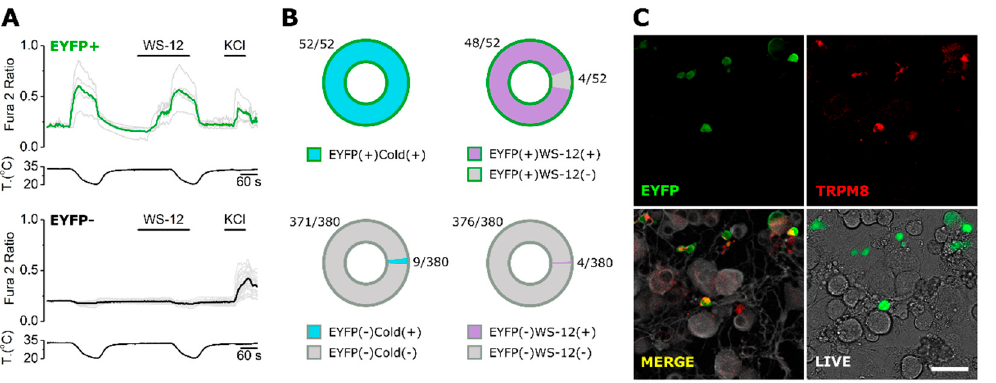
Figure 4. Calcium imaging in DRG-cultured cells from Trpm8 BAC -EYFP + mice. ( A ) Representative traces of calcium transients evoked by mild cold ( ∼ 18–20 °C), WS-12 (10 µM) and KCl (30 mM) in EYFP+ and EYFP − neurons. Traces corresponding to individual cells are shown in grey. Colored traces represent averages of the respective individual traces. ( B ) Proportion of EYFP+ and EYFP − cells responding to cold and WS-12. ( C ) Representative immunocytochemistry performed after a calcium recording. Upper- and bottom-left: confocal images of the immunofluorescence. Green: EYFP. Red: TRPM8 (ECM1 antibody). Grey: β III-Tubulin. Bottom-right: transmitted light and EYFP fluorescence from the same live cells before fixation. n = 432 cells from 2 mice. Scale bar: 50 µm.